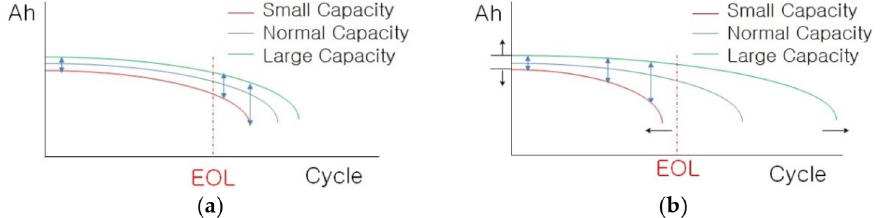
Figure 5. Aging of series-connected batteries. ( a ) Individual charge. ( b ) Effect of capacity variation on single-supply